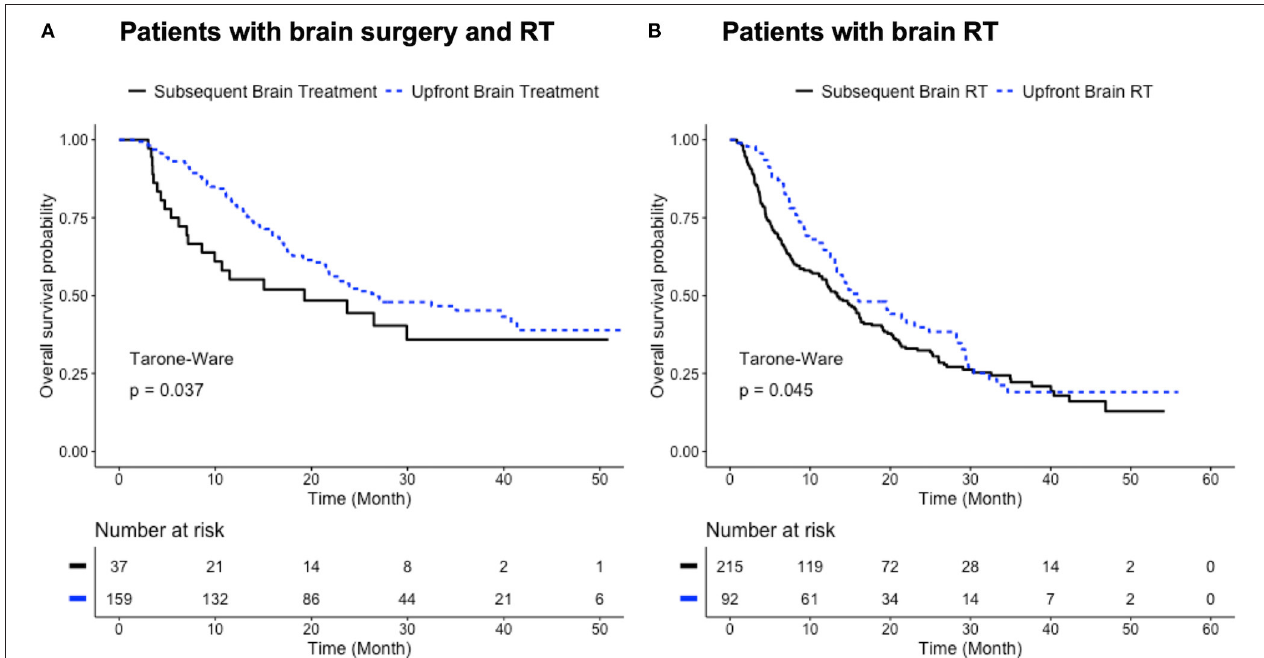
FIGURE 3 | Benefit of upfront brain treatments. (A) Survival curves for patients who received all three local treatments with one brain treatment (surgery or RT) as the first treatment (blue) and lung surgery as the first treatment (black). Median survival time: 26.6 months for Upfront Brain Treatment group; 19.2 months for Subsequent Brain Treatment group ( p < 0.05, Tarone-Ware test). (B) Survival curves for patients who received only brain RT and lung surgery (blue: upfront brain RT; black: subsequent brain RT). Median survival time: 16.0 months for Upfront Brain RT group; 13.4 months for Subsequent Brain RT group ( p < 0.05, Tarone-Ware test). Number of patients with available survival data: n = 159 in Upfront Brain Treatment group; n = 37 in Subsequent Brain Treatment group; n = 92 in Upfront Brain RT group; n = 215 in Subsequent Brain